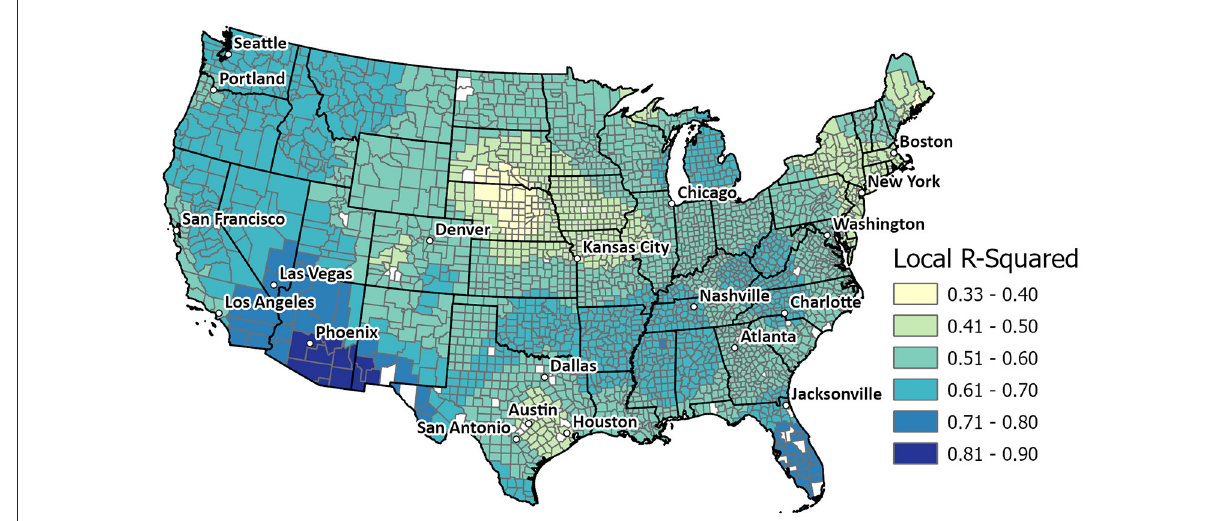
FIGURE4 Local R 2 values for the GWR model. Values ranged from 0.3 to 0.9, with lower values in the Northeast, upper Great Plains and part of Texas, and higher values across the South and West, particularly Arizona and Florida.